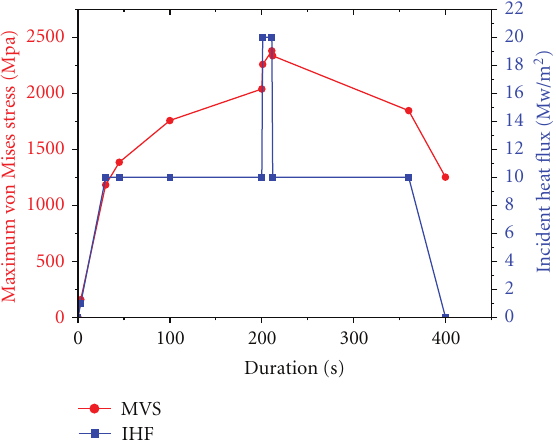
Figure 8: The MVS variation tendency during the 400 s incident heat